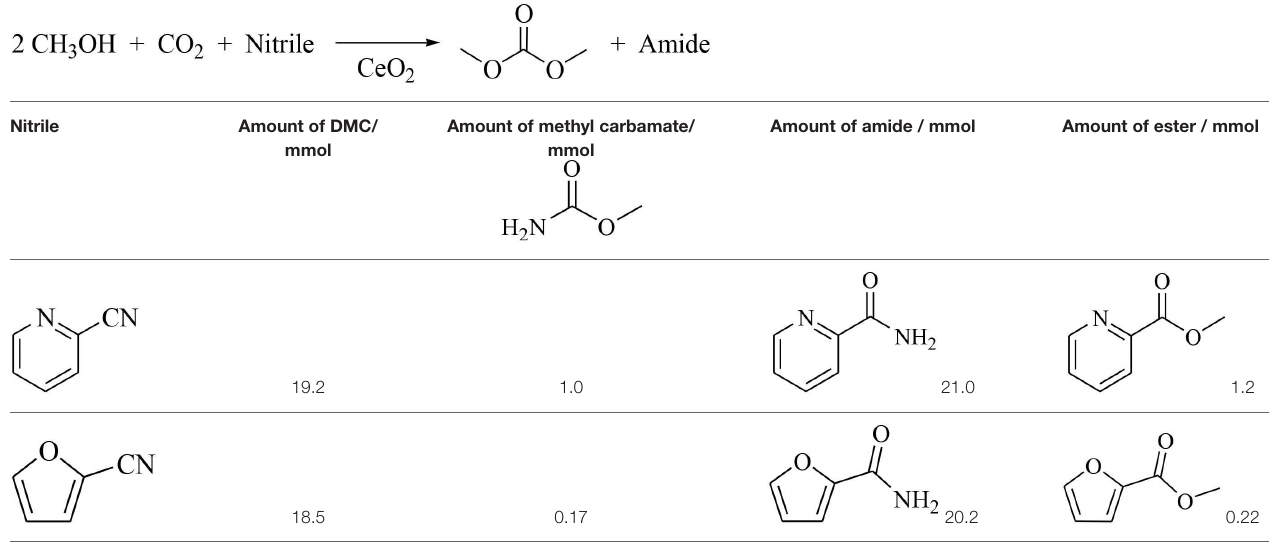
TABLE 4 | Comparison between 2-cyanopyridine and 2-furonitrile in DMC synthesis from CO 2 and methanol on CeO 2 (Gu et al., unpublished data).